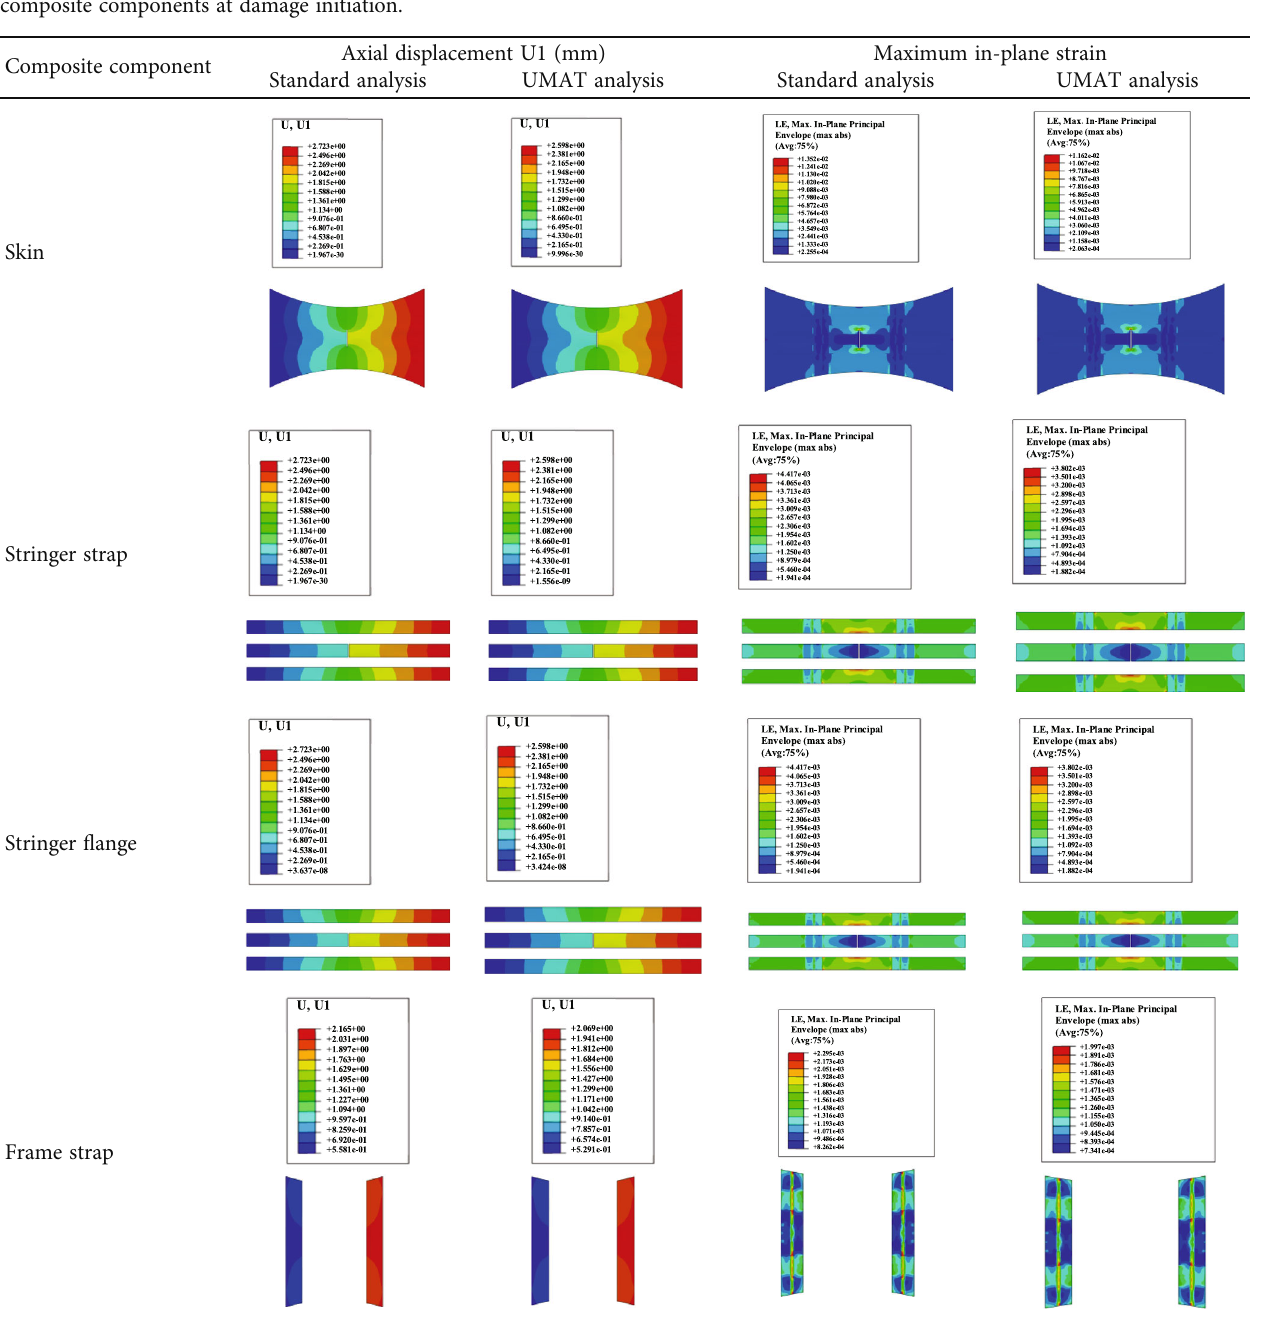
Table 5: Comparison between standard analysis and UMAT analysis in values of axial displacement and maximum in-plane strain in composite components at damage